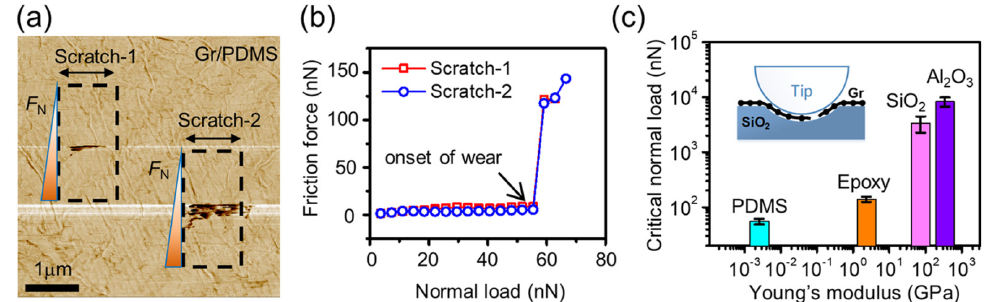
Figure 3. ( a ) A lateral force image of graphene/PDMS sample done under a low load after two scratch tests; the black arrows indicate the scratch direction. ( b ) Variations of friction with the normal load during the scratch tests in ( a ). ( c ) Critical normal loads of graphene on the substrates with different stiffnesses. Reproduced with permission from [67]. Copyright 2019 AIP Publishing.